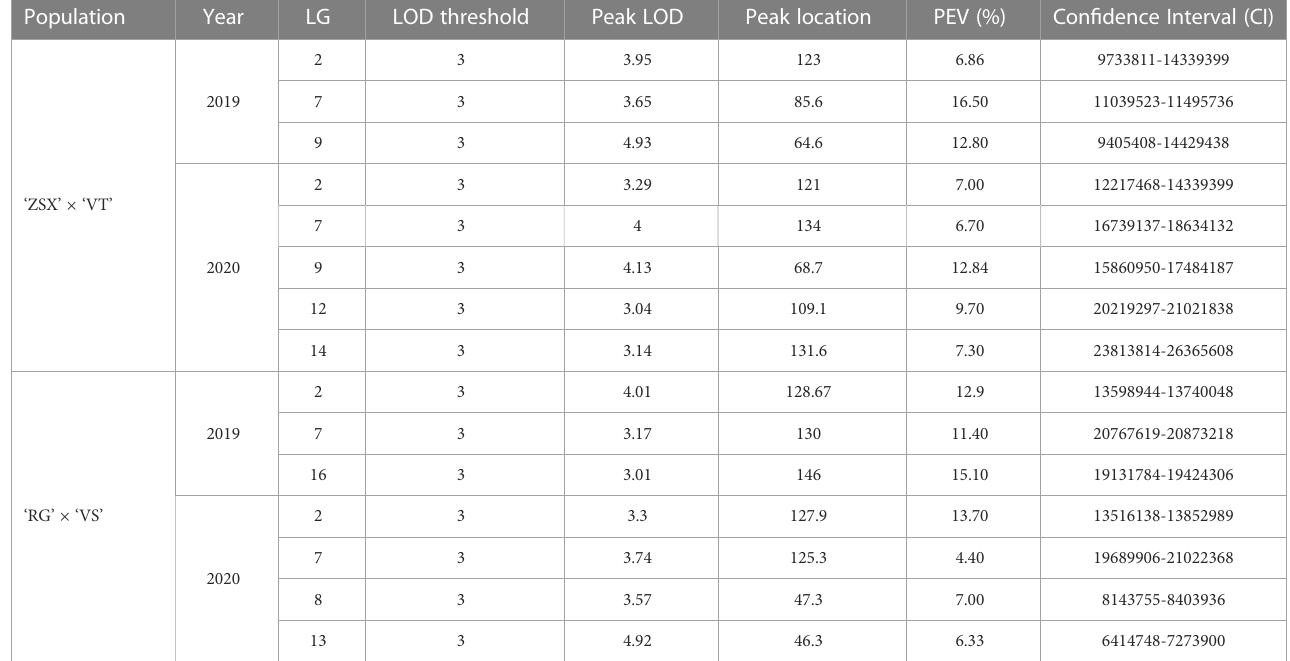
TABLE 1 Gray mold resistance QTL mapping based on the hybrid offspring of ‘ ZSX ’ × ‘ VT ’ and ‘ RG ’ × ‘ VS ’ . Population Year LG LOD threshold Peak LOD Peak location PEV (%) Con fi dence Interval